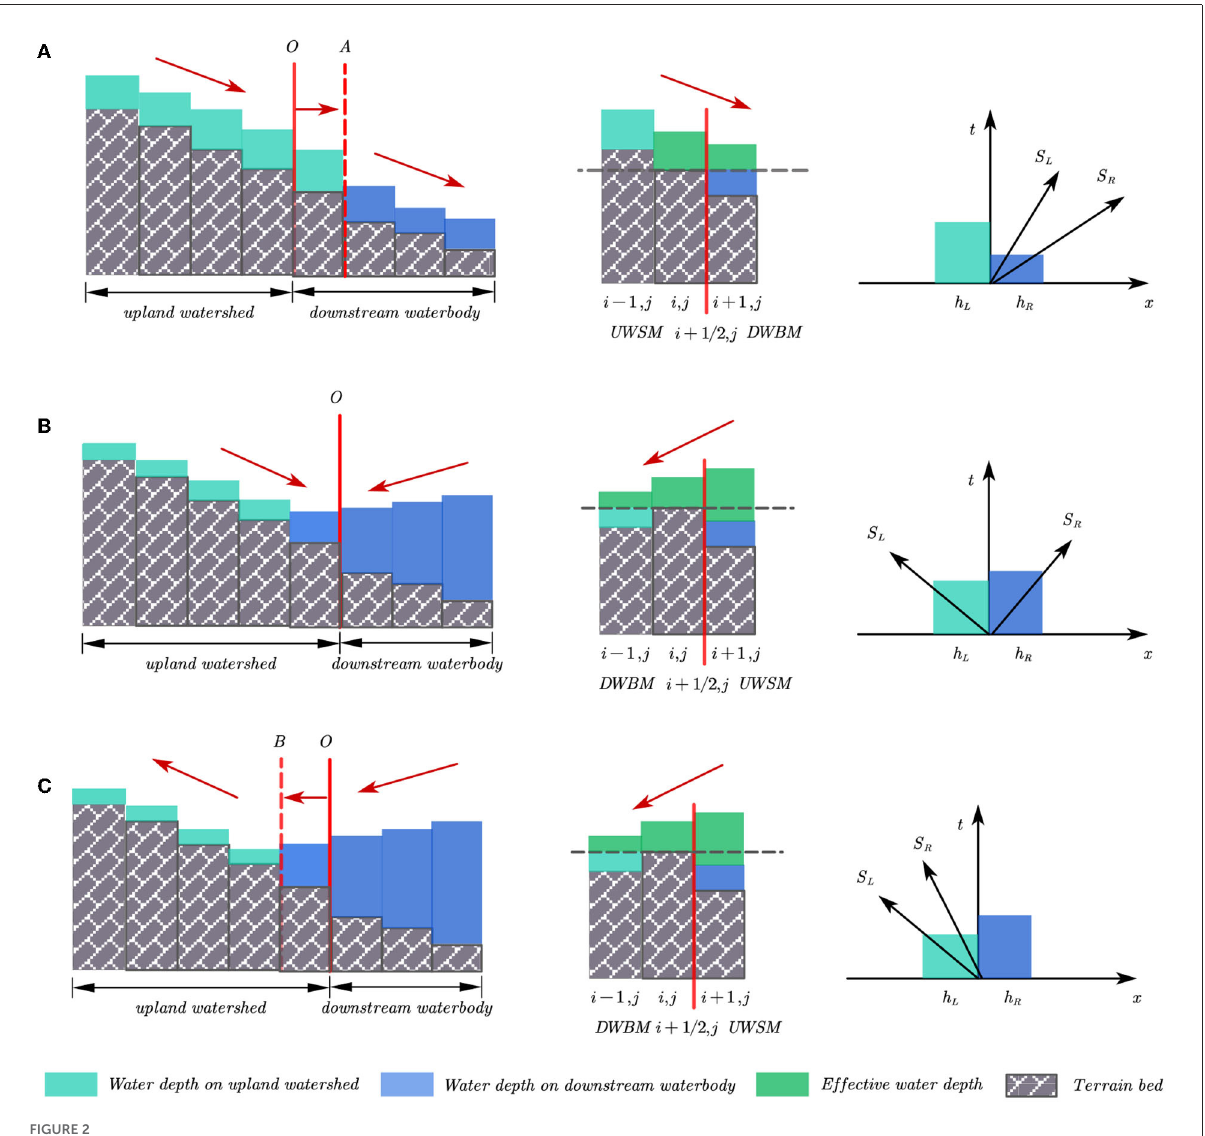
FIGURE2 The moving of coupling boundary: (A) from upland watersheds to downstream waterbodies, (B) unchanged, and (C) from downstream waterbodies to upland